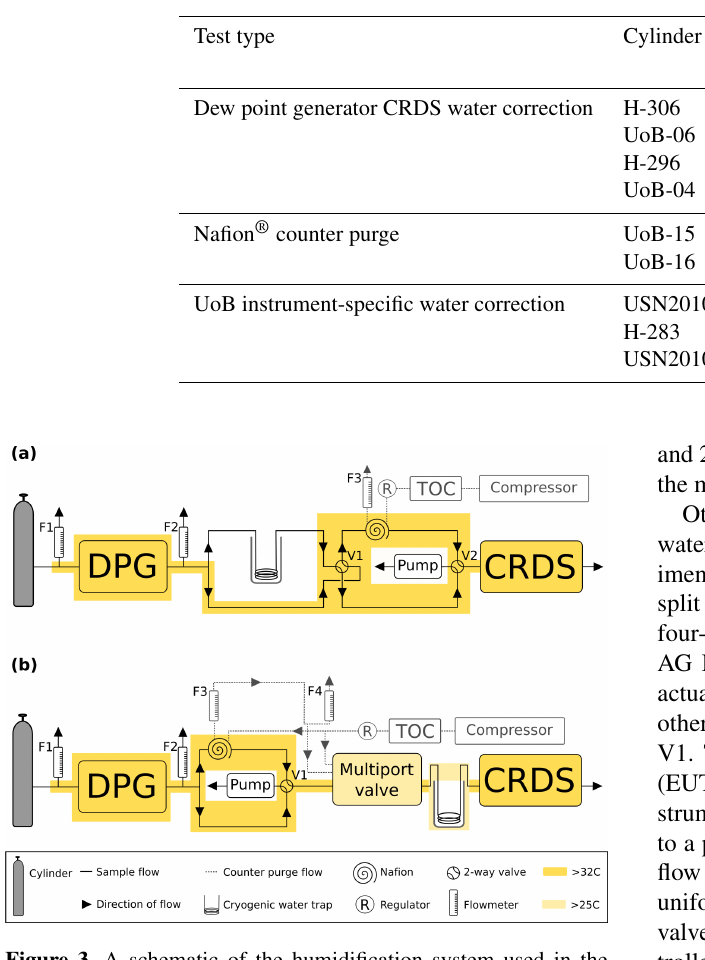
Figure 3. A schematic of the humidification system used in the (a) CRDS water correction assessment and (b) Nafion ® counter purge experiment including the dew point generator (DPG). Here the TOC is the dry gas generator. The black arrows and lines show the direction of sample gas flow. Grey dashed lines and arrows show the flow path of the Nafion ® counter purge gas. Heated zones are shown in